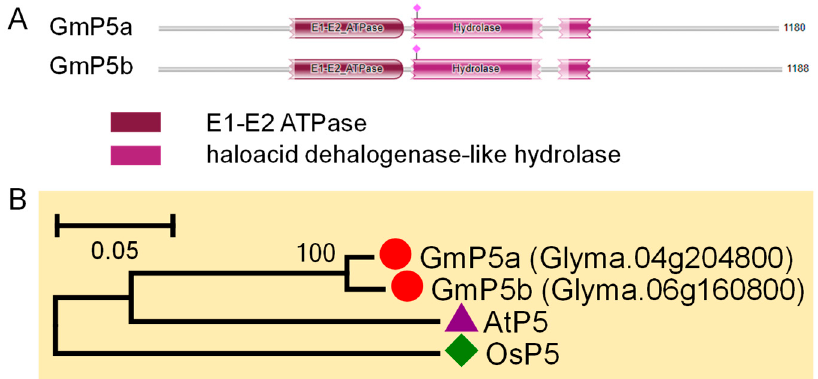
Figure 9. Schematic representation of functional domains of soybean P5 subfamily proteins ( A ) and the phylogenetic tree of P5 subfamily genes from soybean ( Glycine max ), rice ( Oryza sativa ), and Arabidopsis thaliana ( B ): the neighbor-joining phylogenetic tree was made using MEGA6 with 1000 bootstrap replications by aligning full-length amino acid sequences with ClustalW. GmP5s are denoted by red circles, AtP5 is denoted by a purple triangle, while OsP5 is denoted by a green diamonds. The locus name of the soybean gene is shown in brackets.